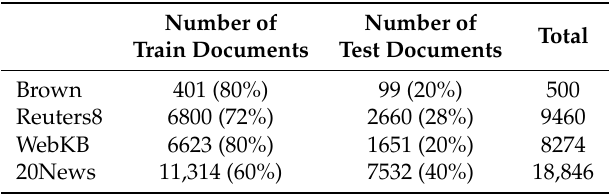
Table 3. The number of train and test documents for each benchmark; note that, 20News and Reuters8 are already split into two sets of training and test documents, for the other two, we used stratified random sampling to split the corpora into training and test data